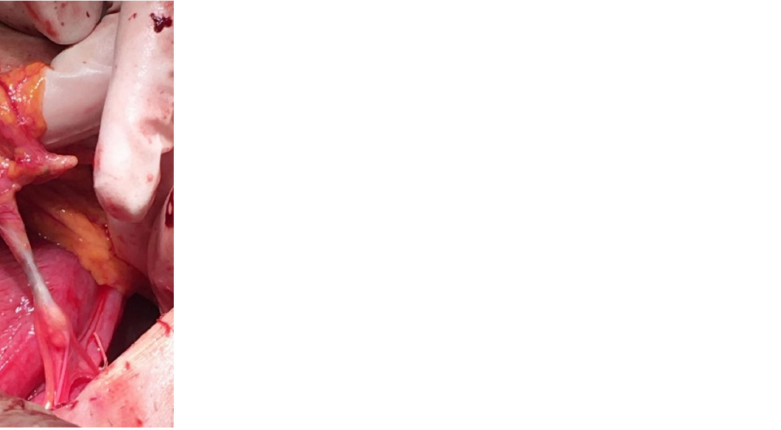
Figure 1. Intraoperative visualization of the ectopic localization of the IUD in the peritoneal